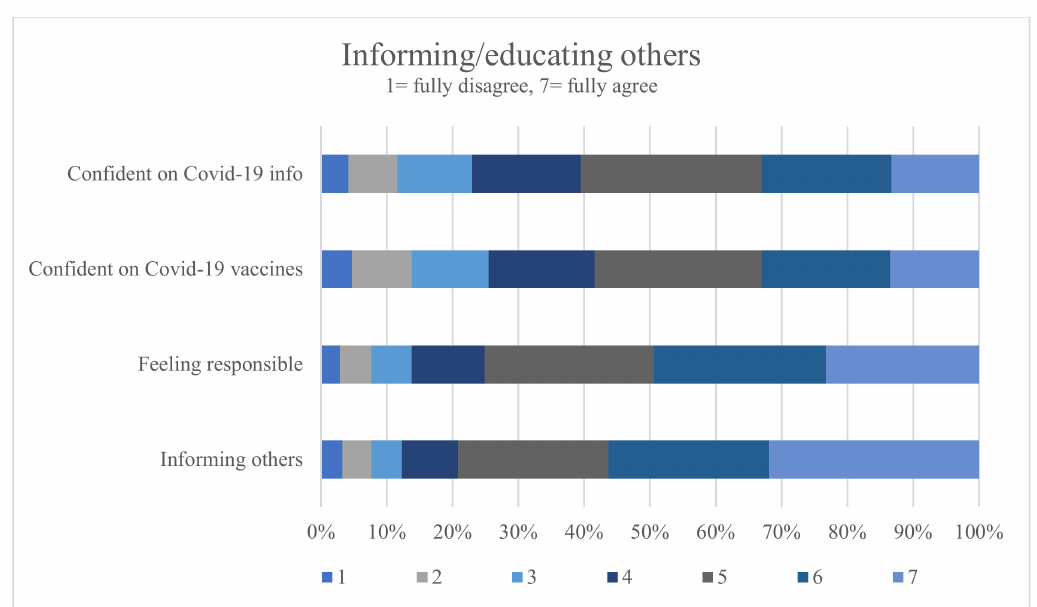
Figure 4. Percentage agreement of questions about informing/educating others and confidence about the learnt